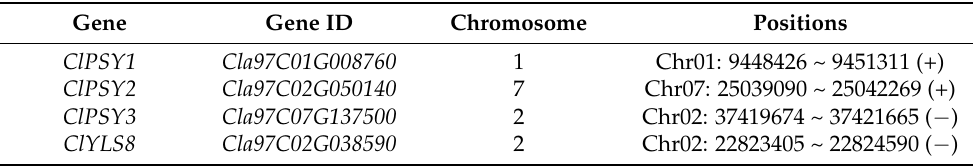
Table 1. Description of watermelon PSY family genes and ClYLS8 .